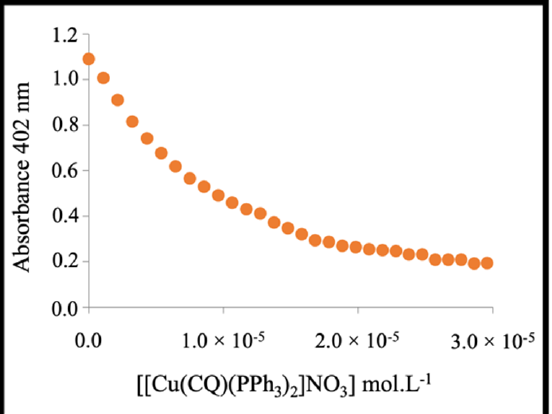
Figure 7. Fe(III)PPIX absorbance at 402 nm in the function of the concentration of complex 1 . The calculated logK association constant (for 1:1 model) for CQDP (at pH 7.4, log K = 5.35 ± 0.03) was found to be similar to those reported elsewhere [41]. The values for complex 1 and 2 were calculated in an analogous manner at pH